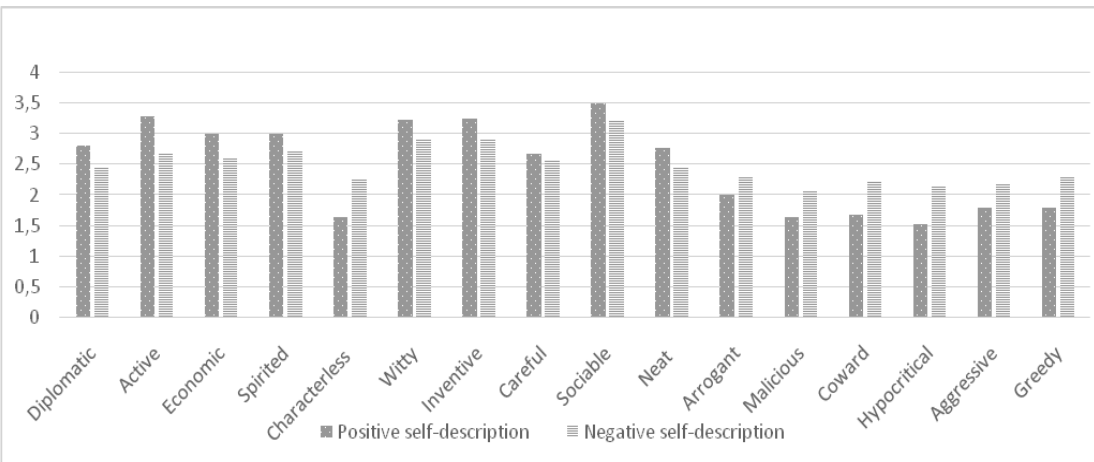
Fig. 1. Differences in description of their own nationality among those with the